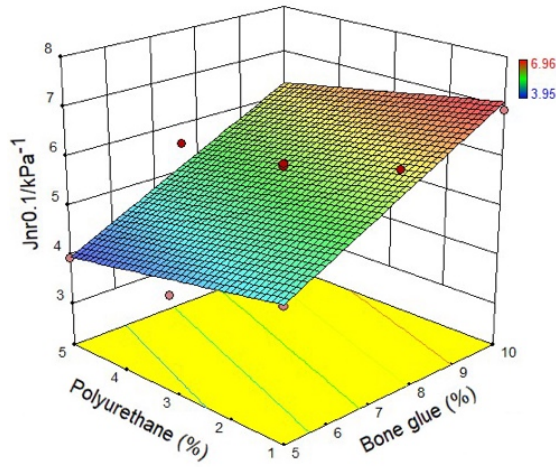
Figure 9. Non-recoverable creep compliance at 0.1 kPa.